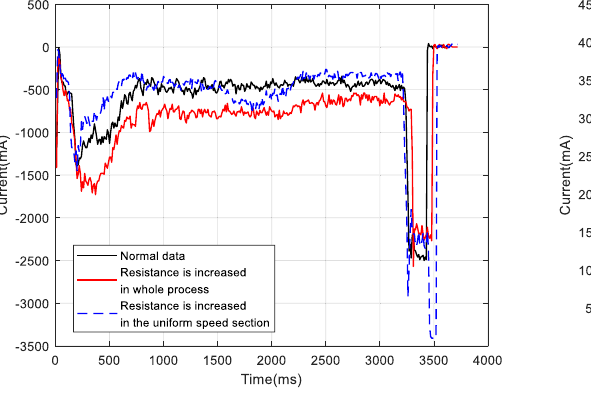
(a) Opening door process (b) Closing door process Fig. 12 Comparison of Table 12 Statistics of misdiagnosis rate of typical subhealth rules Total number of the meansured data in door openings